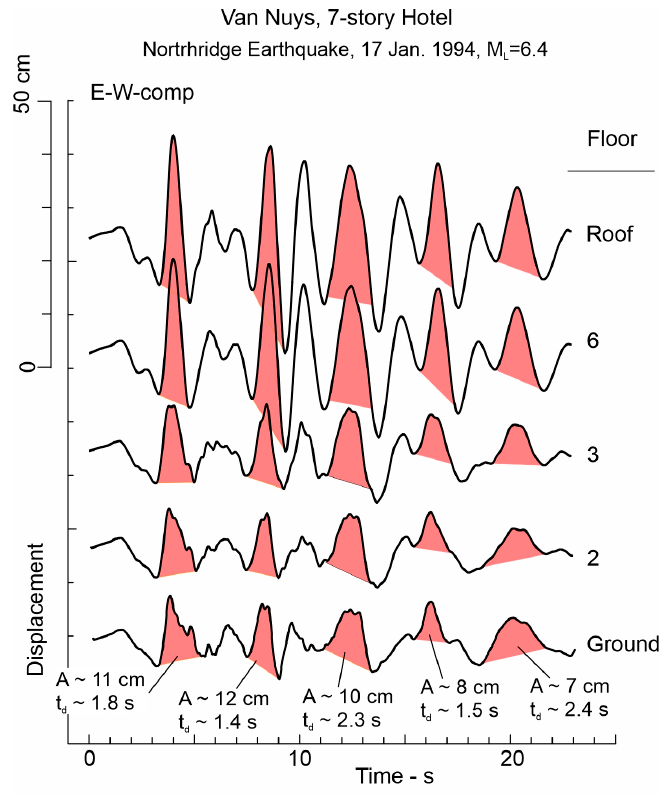
Figure 5. The first 25 s of the EW recorded earthquake displacements in VN7SH at a ground level; the second, third, and sixth floors; and at the roof. Pulses are emphasized by shades in the recorded motion at the ground level, with amplitudes A~11, 12, 10, 8, and 7 cm; durations 1.8, 1.4, 2.3, 1.5, and 2.4 s; at 3.1, 7.8, 11.2, 15.6, and 19.1 s after the trigger, respectively, and propagated up the building.